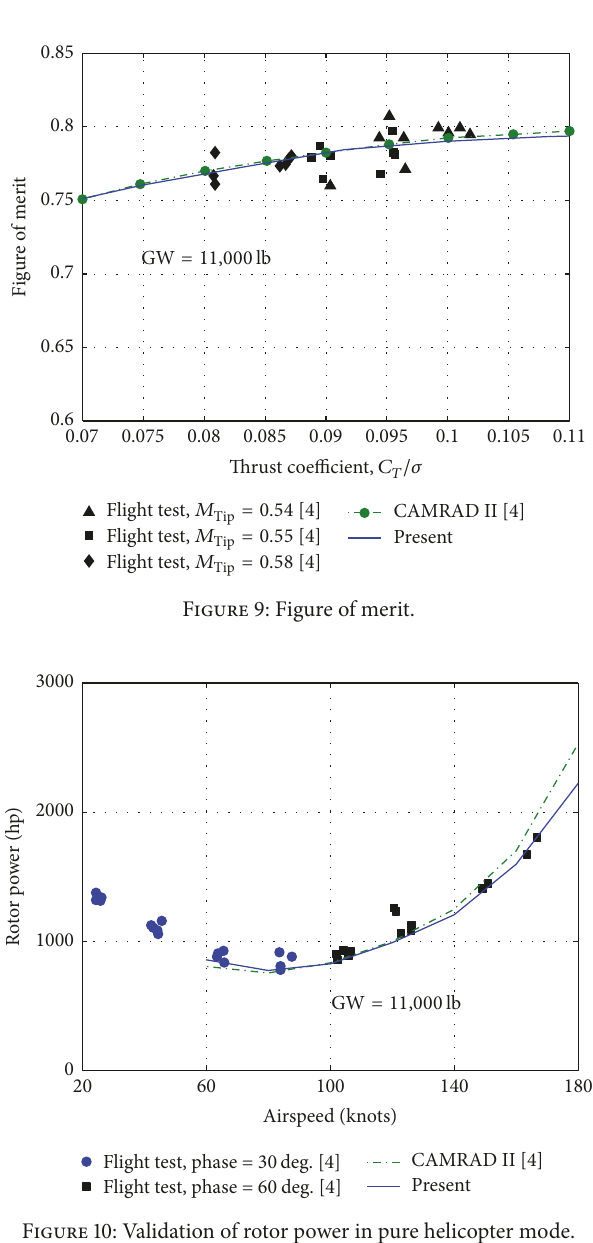
Figure 10: Validation of rotor power in pure helicopter mode.